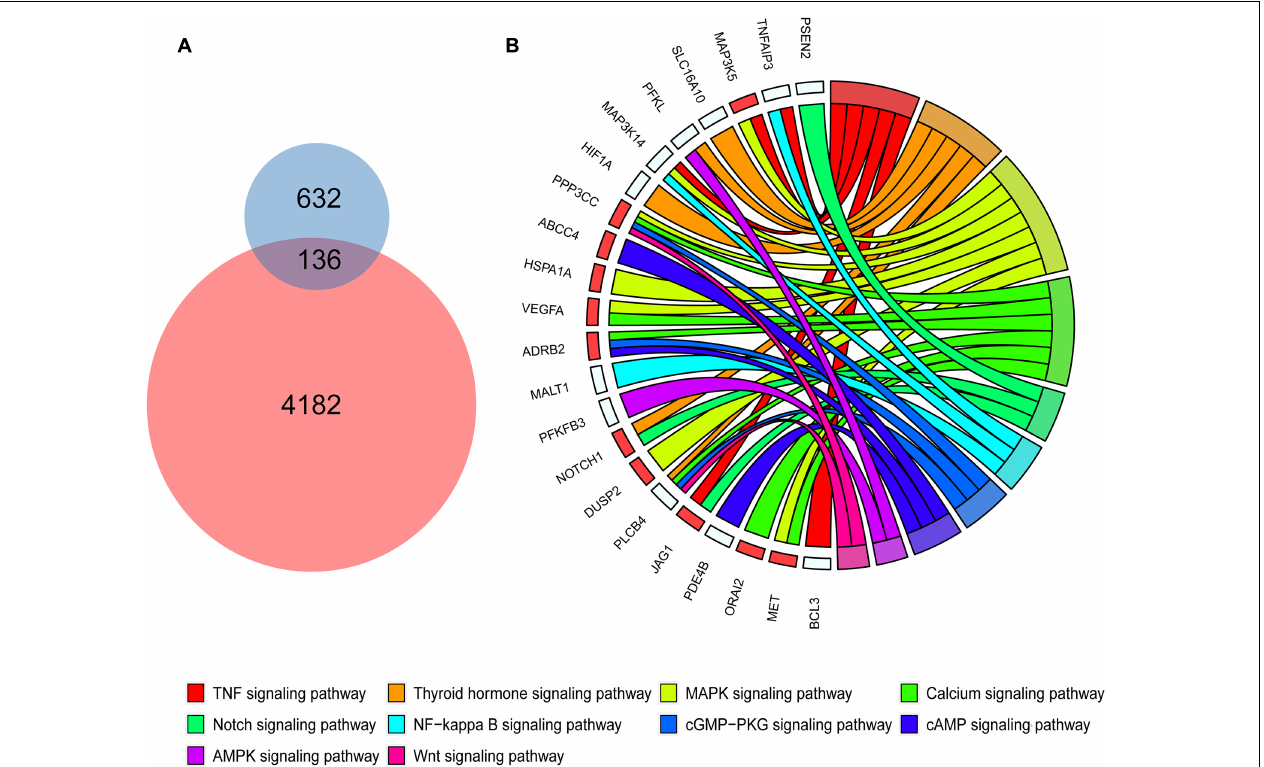
FIGURE 3 | Polarized macrophage marker genes activated by HFD and relevant KEGG pathways. (A) The Venn diagrams shows 136 genes shared between the polarized macrophage marker genes and activated genes with differential peaks in the promoter determined by H3K9me2 ChIP-seq data in mouse white adipose tissue of HFD conditions. (B) The chord diagrams show the KEGG pathways enriched by the 136 shared genes. The red squares represent the genes shared between the 136 genes and differentially expressed genes of macrophages under SCD and HFD